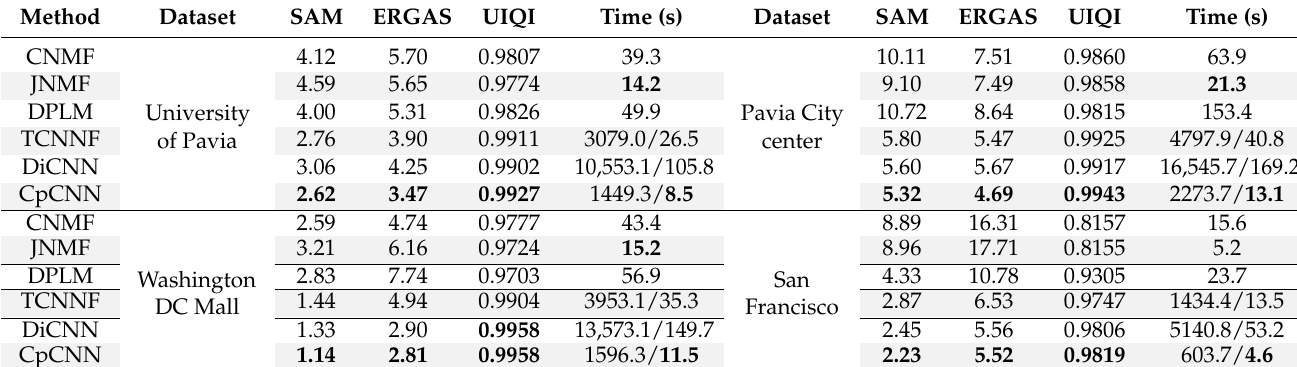
Table 1. Numerical evaluation of hyper-sharpening results under resolution ratio of 2 ( s = 2).